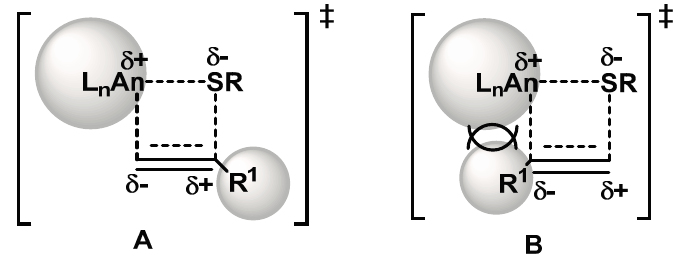
Figure 3. Markovnikov ( A ) and anti-Markovnikov ( B ) transition states for the actinide mediated hydrothiolation of alkynes. Adapted with permission from Weiss, C.J.; Marks,